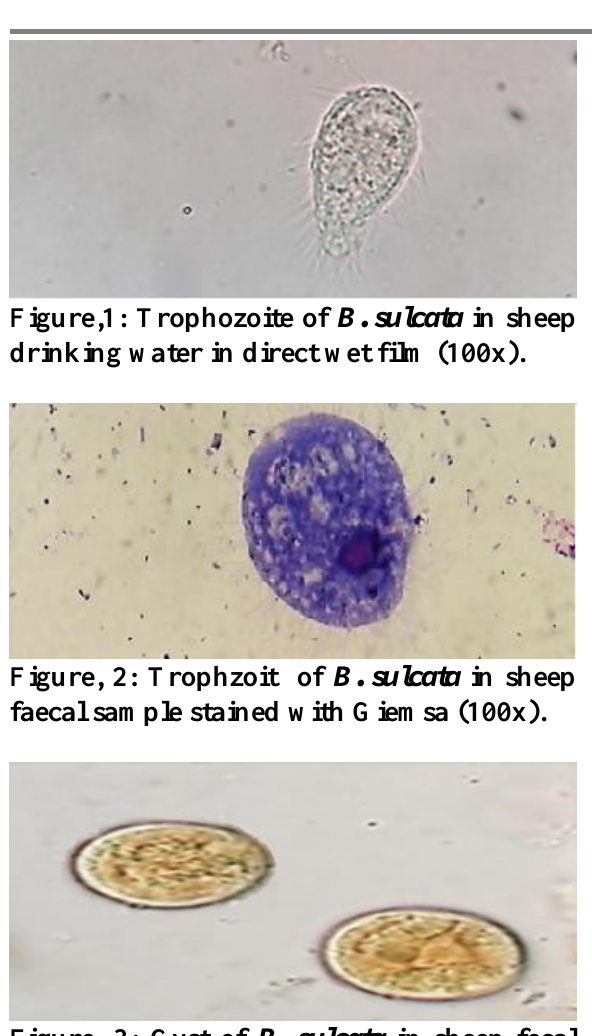
Figure, 3: Cyst of B. sulcata in sheep fecal sample ,in direct wet film